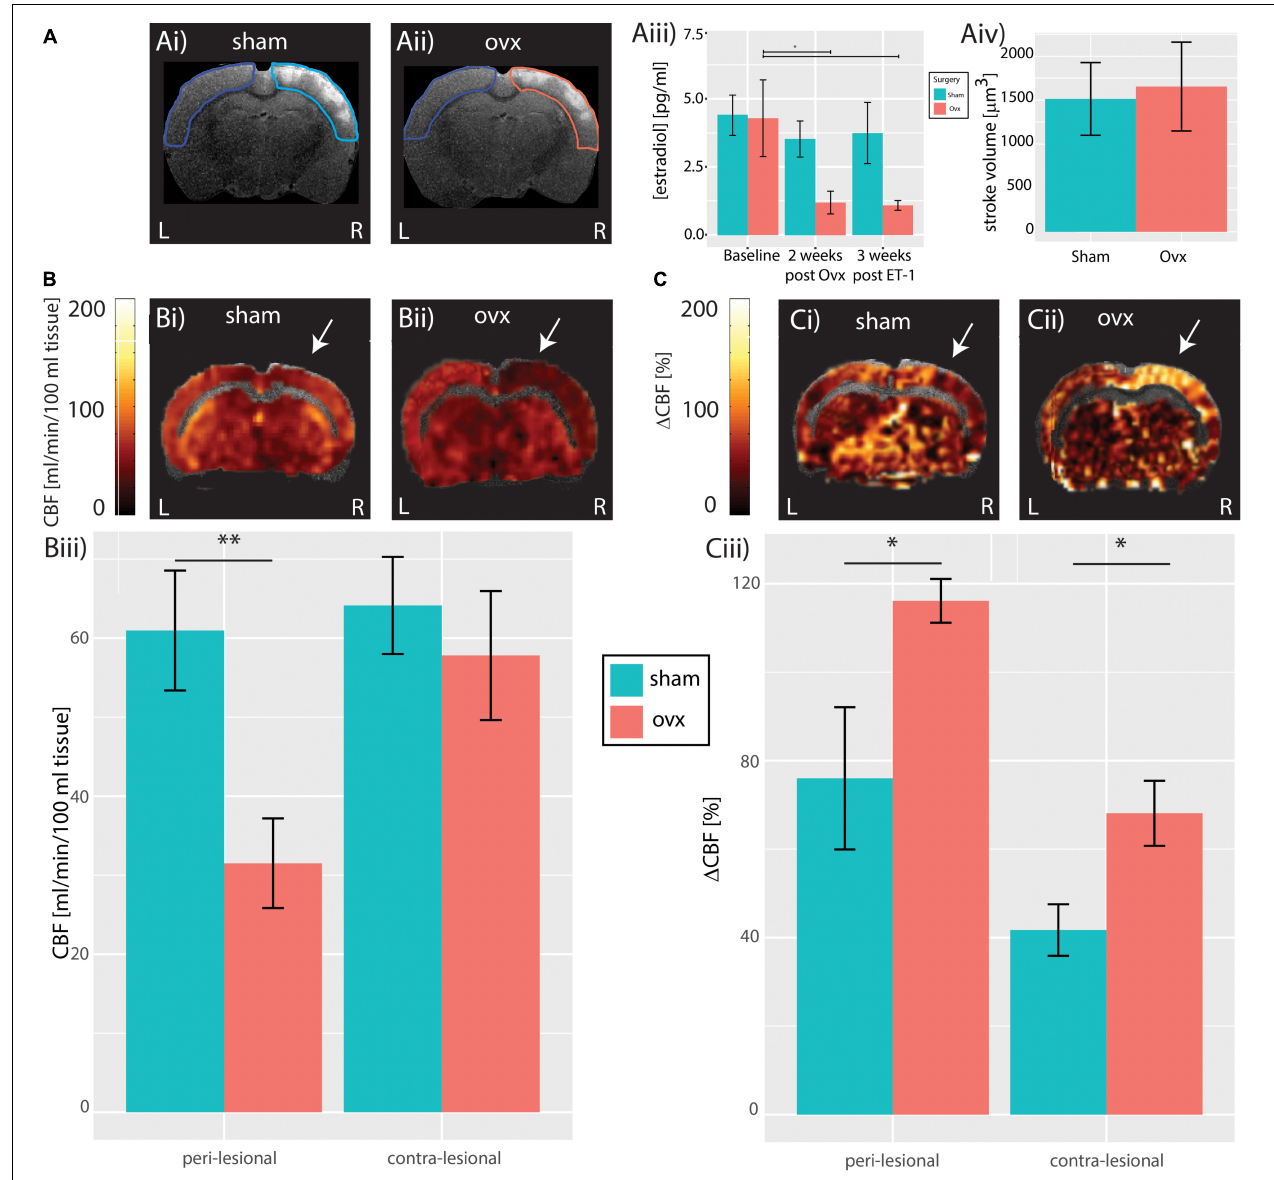
FIGURE 1 | Cerebral hemodynamics. (A) Structural T 2 -weighted MR images of a Sham (Ai) and Ovx subject (Aii) showing anatomically identified peri-lesional tissue in turquoise and pink, respectively, and contra-lesional tissue in blue used for estimation of stroke volume; population analysis of T 2 -weighted hyperintensity does not reveal difference in stroke volume between Sham and Ovx subjects (Aiii) . (B) Resting perfusion in a representative Sham (Bi) and Ovx (Bii) animal. Population analysis revealed reduced blood-flow in the peri-lesional (but not in the contra-lesional) tissue of Ovx subjects compared to that of the Sham group (Biii) . White arrow indicate the region of the slice most proximal to ET-1 injection sites. (C) Response to hypercapnia in a representative Sham (Ci) and Ovx (Cii) animals. Population analysis revealed increased response to hypercapnia both in the peri-lesional and in the contra-lesional tissue of Ovx animals compared to the Sham group (Ciii) . ∗ p < 0.05 and ∗∗ p < 0.01.